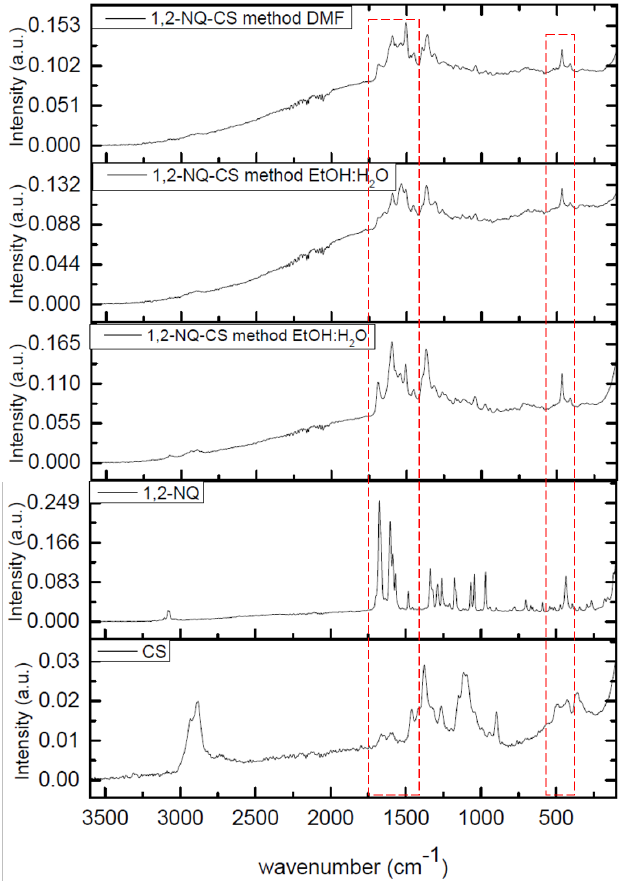
Figure 13. Raman spectra of 1,2-NQ-CS obtained by the 1,2-NQ-CS DMF method; 1,2-NQ-CS ob- tained by the EtOH:H 2 O method, 1,2-NQ-CS following the EtOH:H 2 O + Et 3 N method; sodium 1,2- naphthoquinone-4-sulfonate (1,2-NQ), and chitosan